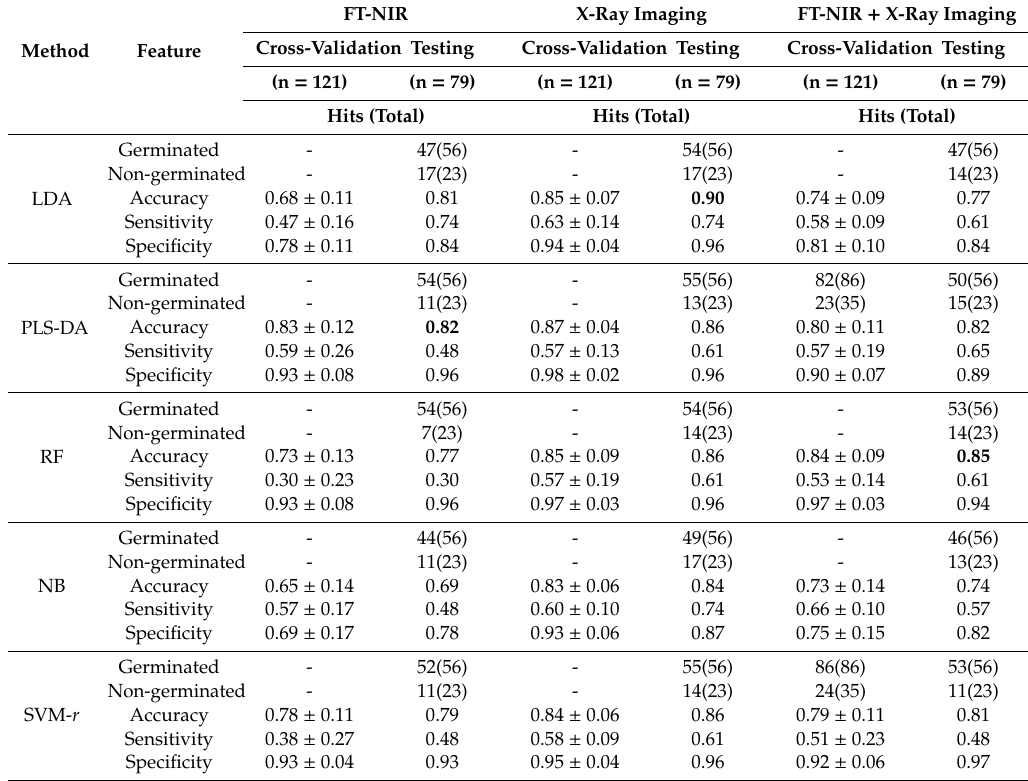
Table 2. Number of seeds correctly classified for germination capacity using descriptors generated by Fourier transform near-infrared (FT-NIR) spectroscopy, X-ray imaging, and the combination of FT-NIR spectroscopy and X-ray